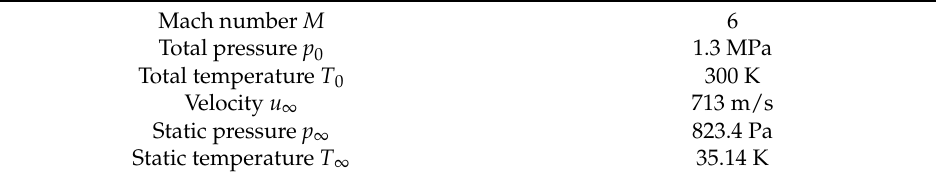
Figure 5. Schematic diagram of the simplified model. Table 1. Parameters of the freestream used in the